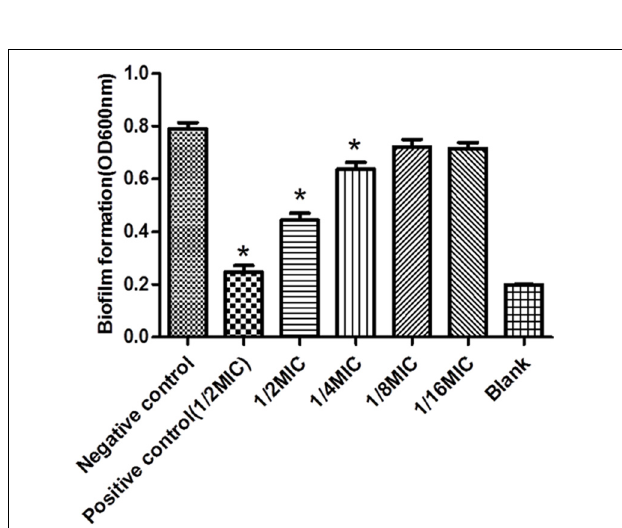
FIGURE 2 | Effect of Rhizoma Coptidis at different concentrations on S. suis ATCC700794 biofilm formation. Data are expressed as means ± standard. Significant decrease ( ∗ p <0.05) compared to control biofilm formation of S. suis in vitro